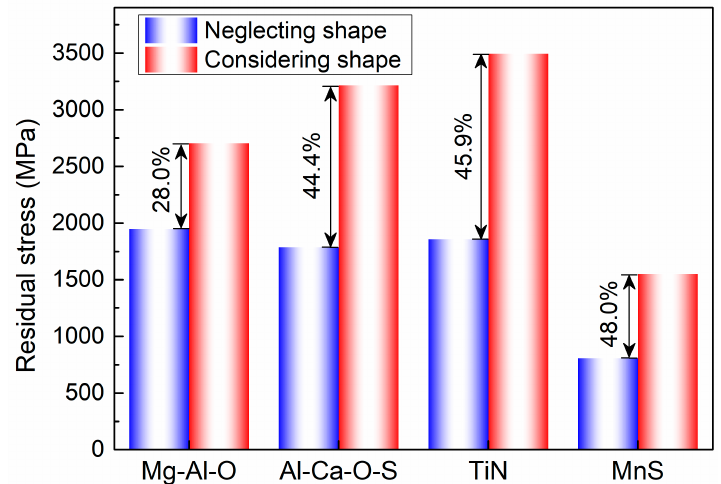
Figure 9. Comparison between the maximum residual stress around different types of inclusions neglecting shapes and considering shapes.